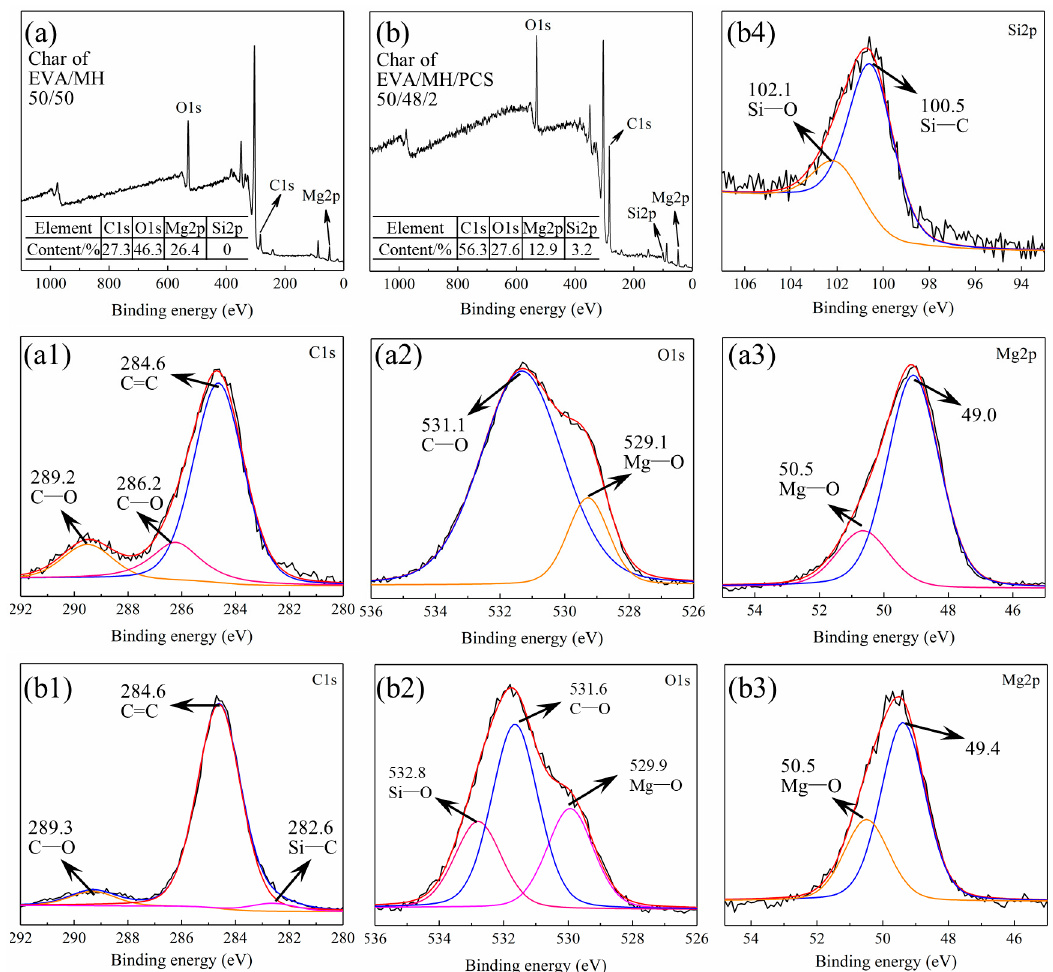
Figure 11. The XPS spectra of the surface char of ( a ) survey spectrum of EVA/MH and ( b ) survey spectrum of EVA/MH/PCS. ( a1 , b1 ) C1s, ( a2 , b2 ) O1s, ( a3 , b3 ) Mg2p, and ( b4 ) Si2p.